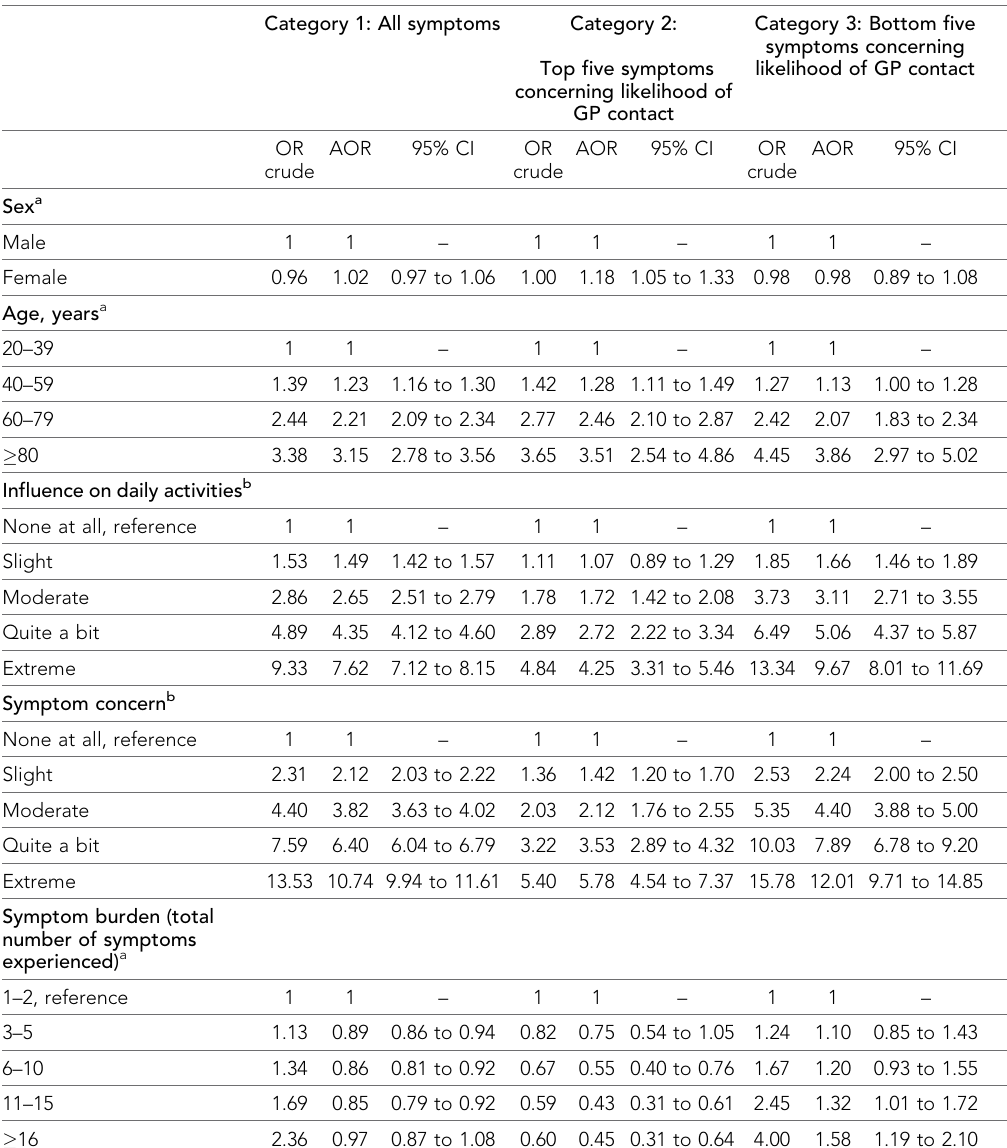
Table 2. Odds ratios for GP contact with a symptom stratified in three different symptom